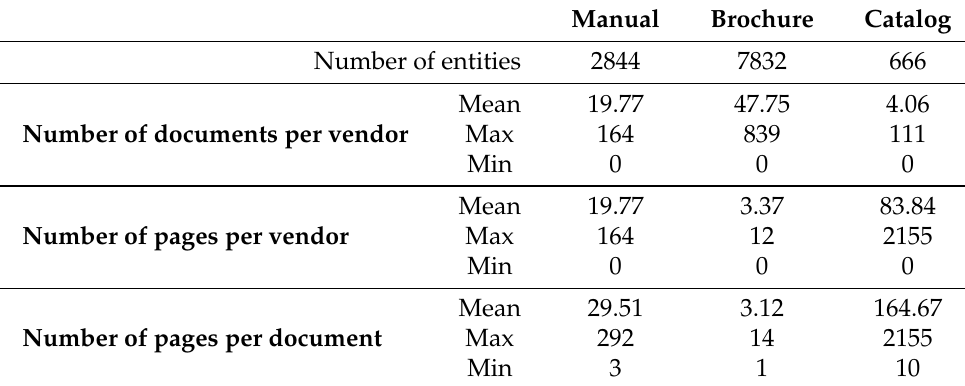
Table 1. ICS vendor and documents statistics in repository.